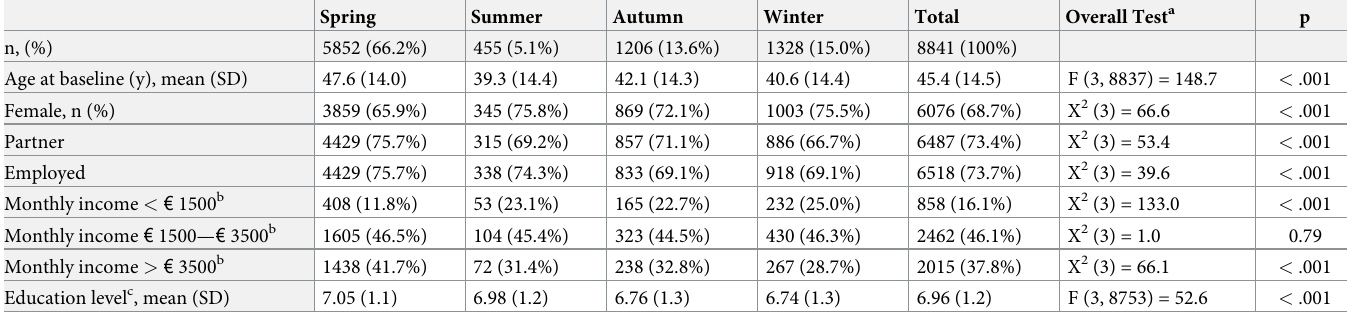
Table 1. Seasonal distribution of demographic